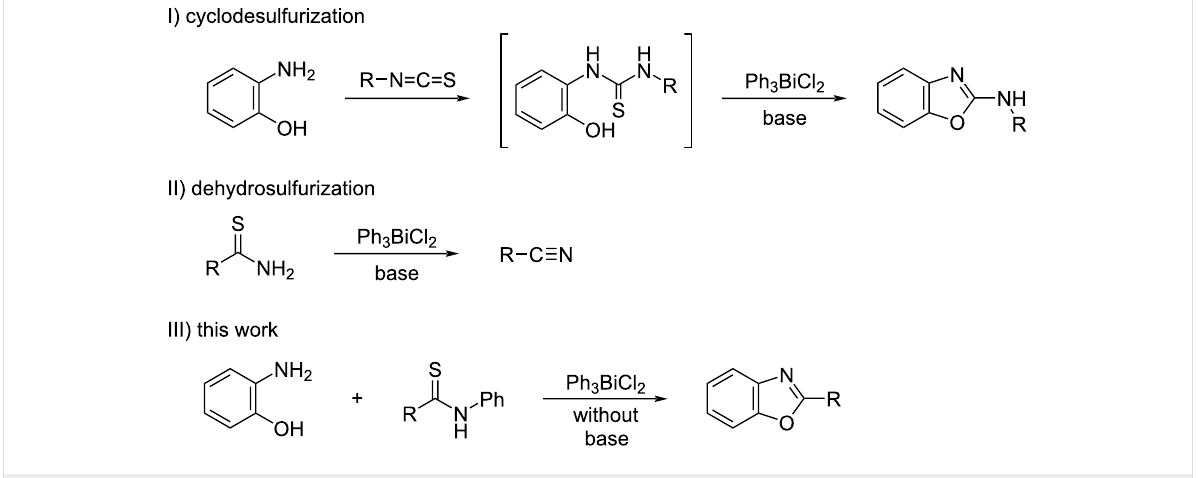
Scheme 1: Utilization of Ph 3 BiCl 2 for organic reactions involving